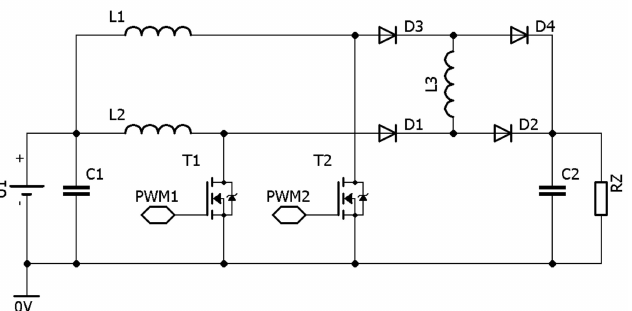
Figure 3. Circuit diagram of perspective dual interleaved boost converter with magnetic flux re- set